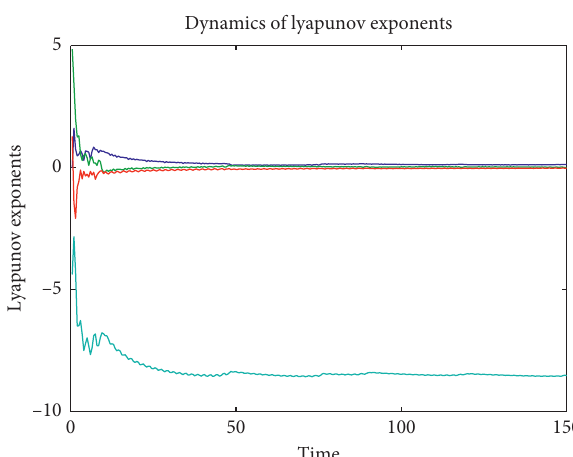
Figure 4: Dynamics of Lyapunov exponents with respect to Case